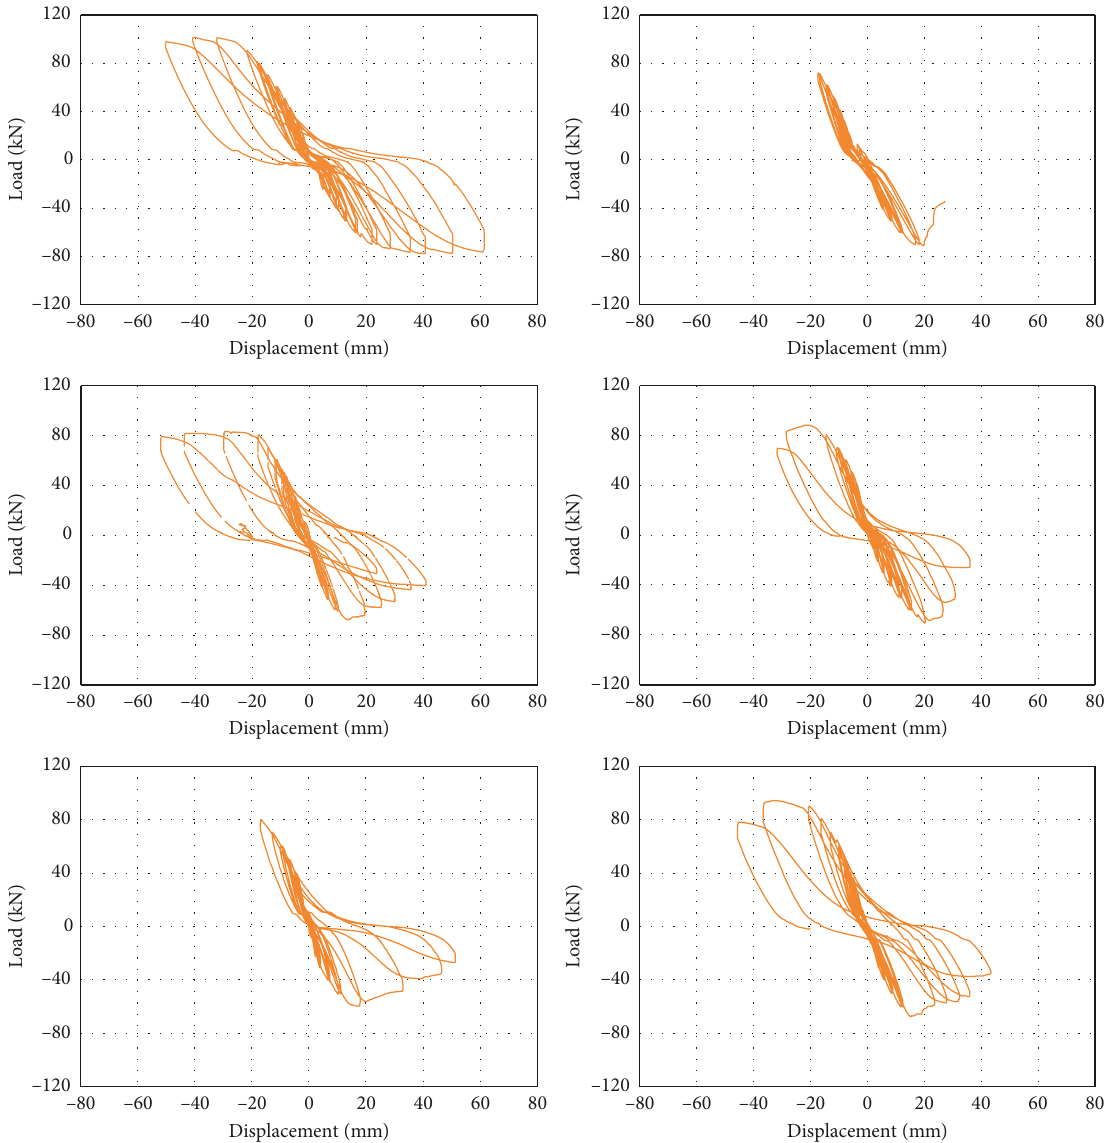
Figure 9: Load-displacement cyclic load of the samples. (a) Target; (b) control; (c) Sample 1; (d) Sample 2; (e) Sample 3; (f) Sample 4.